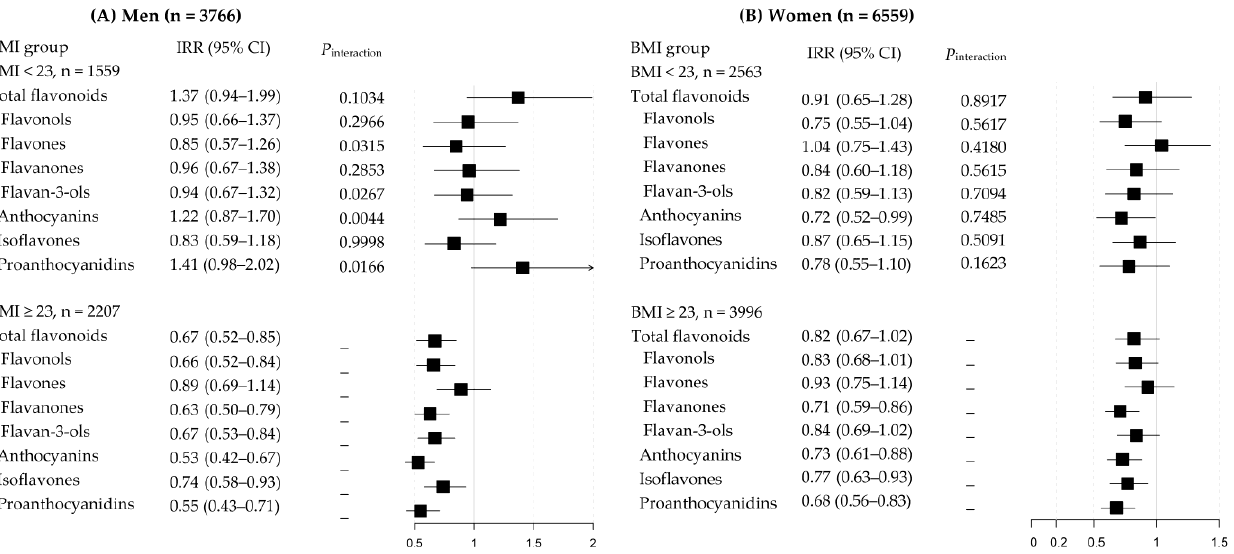
Figure 1. Incident Rate Ratios (IRRs) and 95% Confidence Intervals (CIs) of hypertension in the highest quartile of flavonoids (vs. the lowest quartile) based on BMI group; ( A ) men ( B ) women. The multivariable model was adjusted for age (years), a higher education level ( ≥ 12 schooling years), regular exercise ( ≥ 3 times/week and ≥ 30 min/session), smoking (current/past/non-smokers for men and current/non-smokers for women), current drinkers (yes or no), body mass index (BMI), total energy intake (kcal/d), family history of hypertension (yes or no), menopausal status (yes or no for only women), and the baseline blood pressures. P -interaction was tested by adding the cross-product term of quartiles of flavonoid and BMI groups ( ≥ 23.0 kg/m 2 , yes/no).